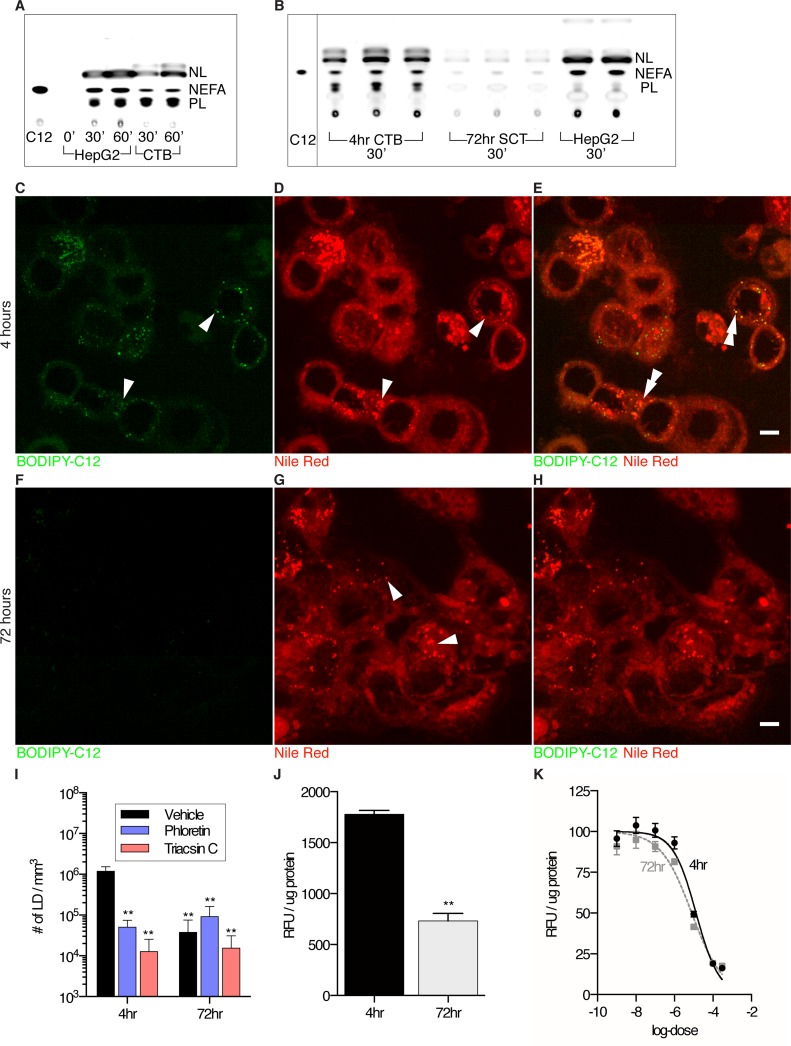
BODIPY-C12 incorporation into lipid droplets in primary cytotrophoblasts incubated for 15 or 30 min.Cytotrophoblasts (CTB) were in two states of maturation after being in culture for 4hr(A,C-E) or 72hr which leads to syncytialization (SCT) (B,F-H). (A,B) Analyses of BODIPY- C12 incorporation into lipid subclasses via thin-layer chromatography in CTB and SCT in vitro (A) Time course of HepG2 cells (positive control) and primary cytotrophoblast incubated continuously with BODIPY-C12. BODIPY-C12 is incorporated into neutral lipids (NL) and phospholipids (PL) within 30 minutes indicating esterification of this long-chain fatty acid analogue. NEFA, non-esterified fatty acid. (B) CTB incorporate more BODIPY-C12 into esterified lipid subclasses than SCT in vitro within 30 minutes. (D) Cultures (D,E and G,H) were stained with Nile Red to visualize neutral lipid droplets (LD). Images (C,F) shows that BODIPY-C12 incorporation is greater among CTB than among SCT. (E) In CTB, BODIPY-C12 merges with Nile-Red in LD. (H) When CTB have undergone syncytialization, they incorporate very little BODIPY-C12 in LD. (I) Quantification of lipid droplets shows that cultured (4 hours) cells accumulate more BODIPY-C12 LD than those that have syncytialized (72hrs). Phloretin and triacsin C significantly reduce BODIPY-C12 LD accumulation in cytotrophoblasts but not in syncytialized cells. (J) The uptake of BODIPY-C12 using a 96-well plate-reader indicates that uptake is higher in cytotrophoblast before syncytialization (K) The log-dose response curve of CB-2, a FATP2 inhibitor, supports that both cytotrophoblast and syncytialized cells are equally sensitive to inhibition of BODIPY-C12 uptake by CB-2. The efficacy of this inhibition of BODIPY-C12 uptake suggests that FATP2 largely mediates long-chain fatty acid uptake in these cells. TLC plates are representative of 3 technical replicates. (C-H): Scale Bar: 5μm, LD (arrow heads), co-localization (double arrowhead). Image intensity ranges are the same in all panels (I-K): Data are mean ± SEM; (I) n = 6 for each group. 2-way ANOVA, (J,K) n = 4. Paired t-test. * = p<0.05, ** = p<0.01 vs CTB vehicle.